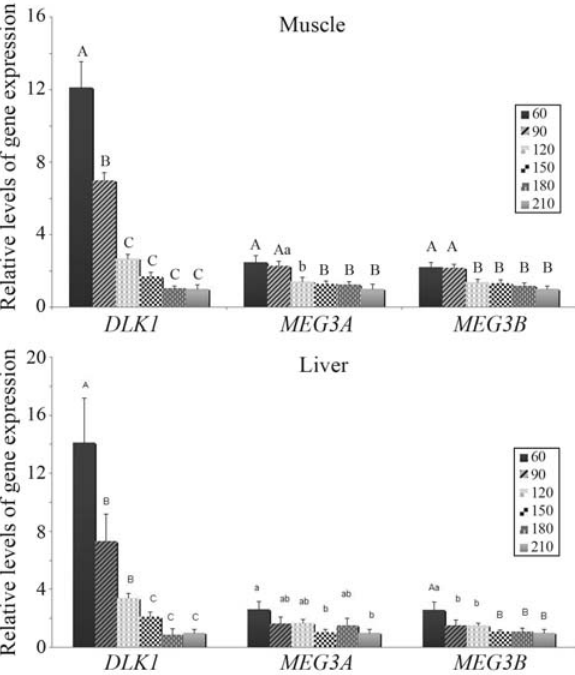
Figure 2 - DLK1 , MEG3 var.1 and MEG3 var. 2 gene expression in the longissimus dorsi muscle (a) and liver (b) of pigs at 60, 90, 120, 150, 180 and 210 days after birth. Values are presented as mean (cid:3) SEM. Different letters indicate significant differences. Capital letters – p < 0.01, small let- ters – p <